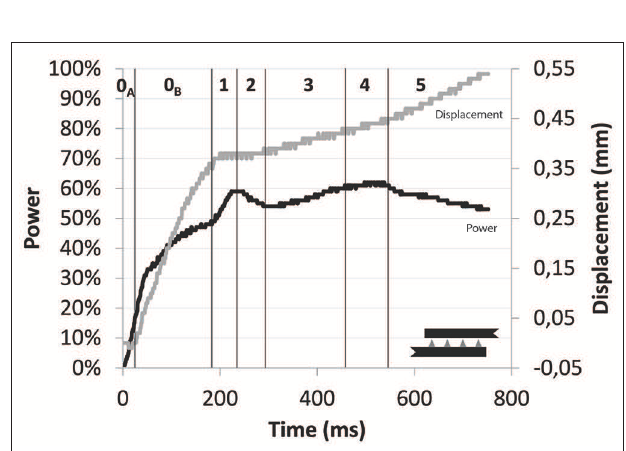
FIGURE 6 | Power and displacement curves for ultrasonic welding of CF/PPS single-lap coupons with molded triangular energy directors (energy director height = 0.5mm, angle at the tip = 90 ◦ , welding force 500N, vibration amplitude 86 µ m peak-to-peak). Definition of stages 0 A, 0 B , and 1–5 in the welding process. Reprinted with slight adaptions from Villegas and Palardy (2017) with permission from Taylor and